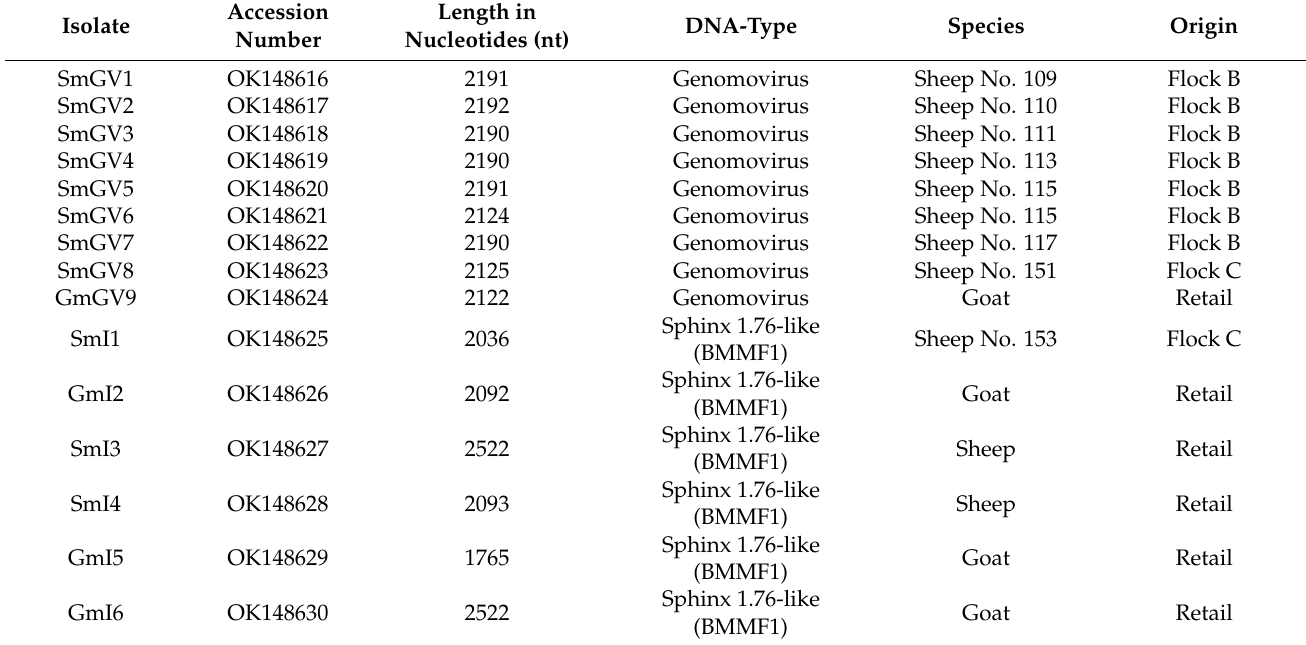
Table 1 summarizes the overall information on the origin and basic features of circular DNA elements detected. Table 1. Overview of all circular genomes detected in this study with accession numbers, sequence length, DNA-types, species and origin of isolation. Interestingly, two genomoviral sequences were isolated from sheep No. 115.